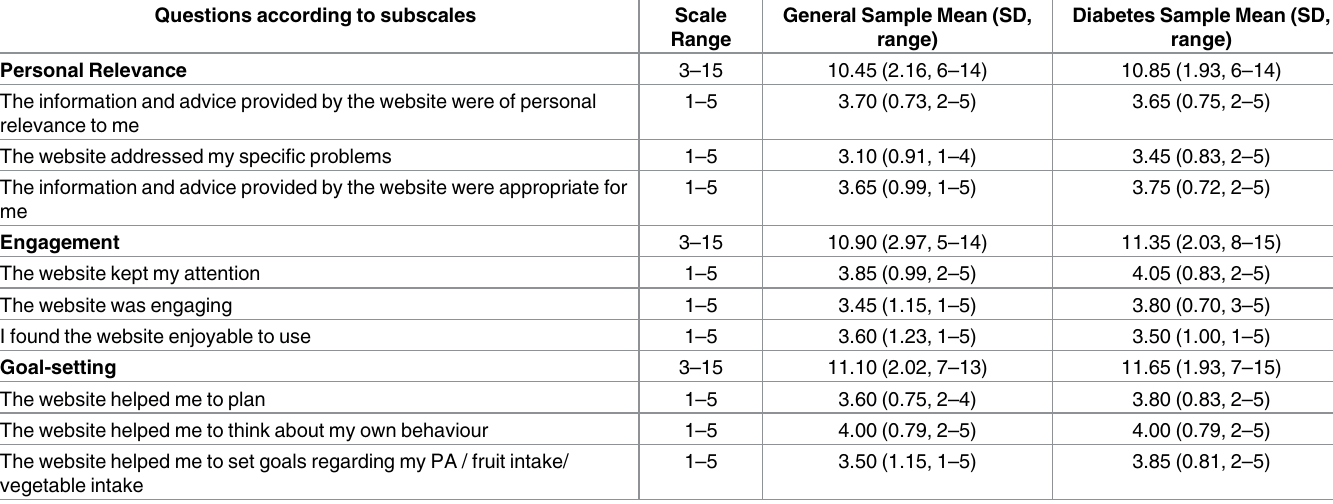
Table 2. Results from the Website Evaluation